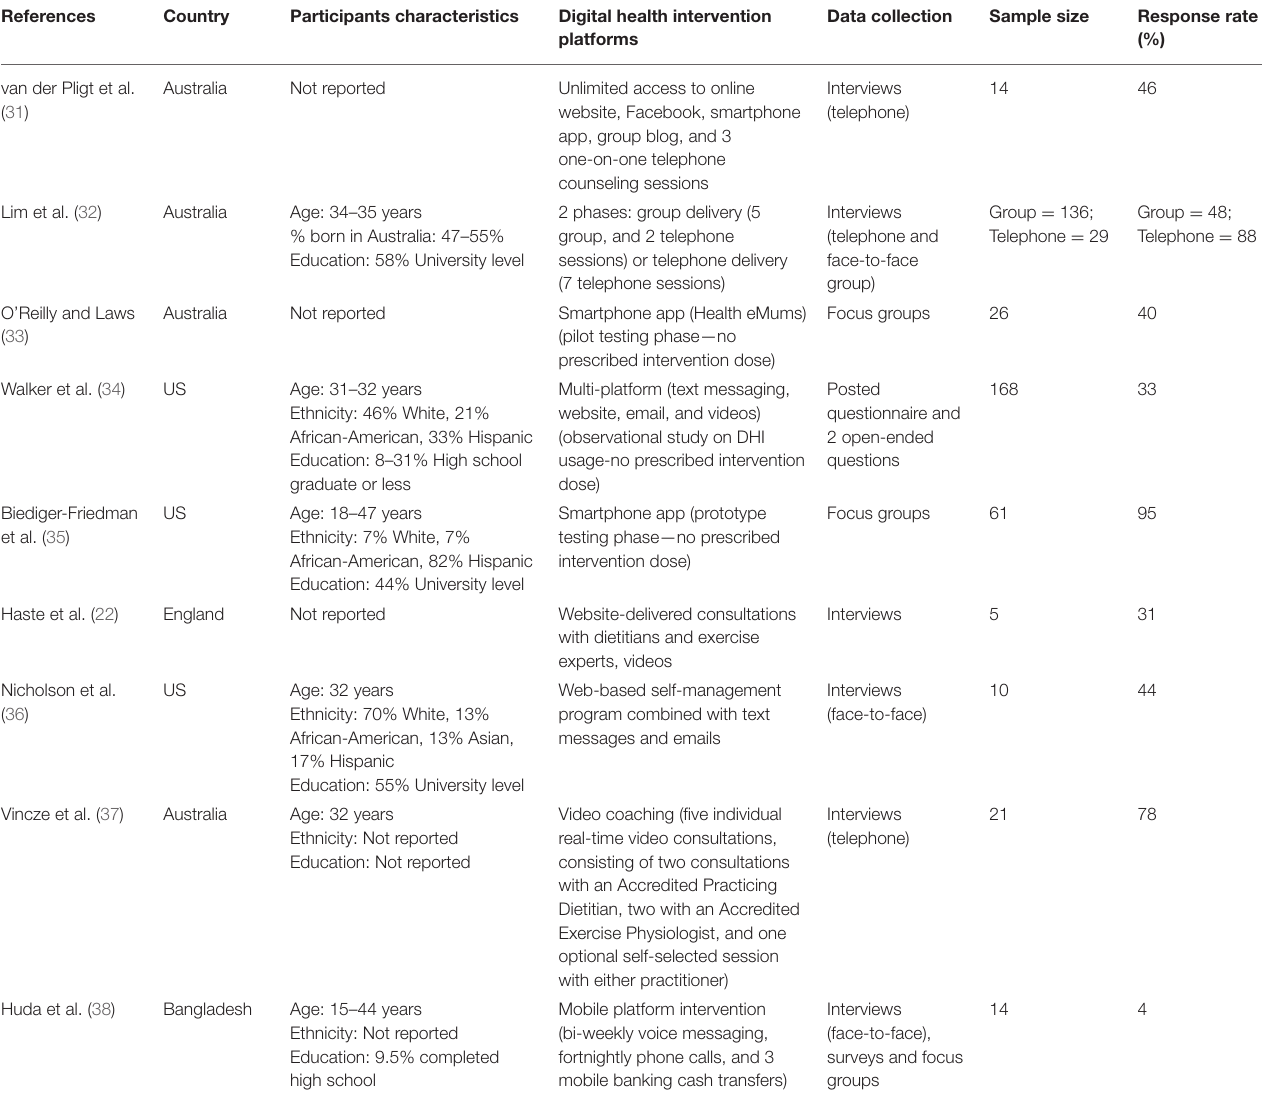
TABLE 1 | Characteristics of the studies included in the qualitative